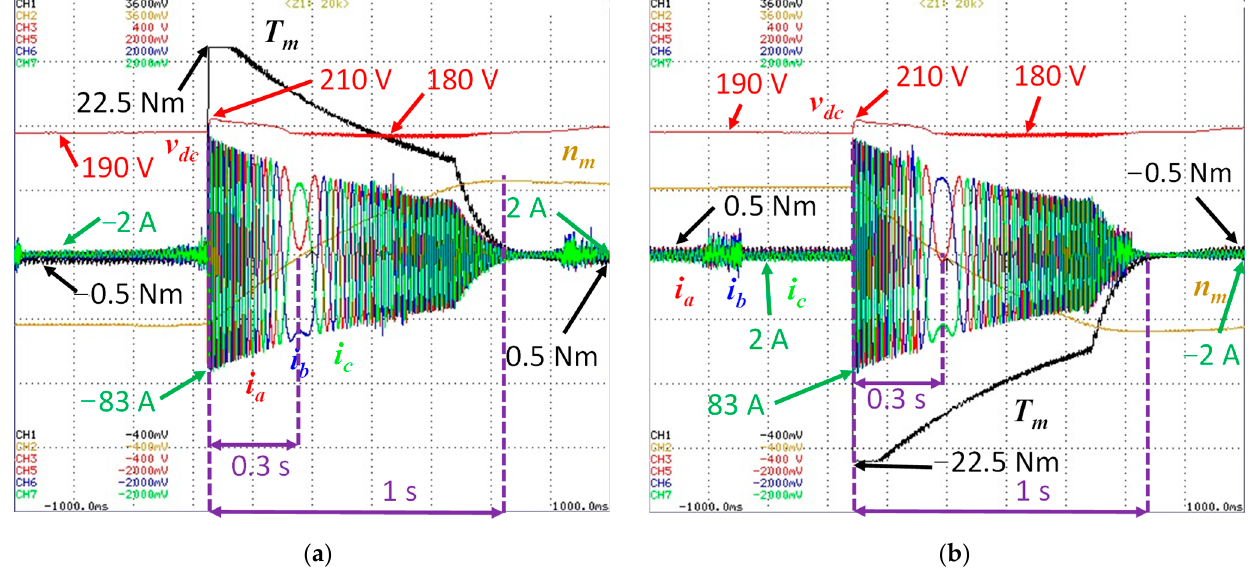
Figure 19. Experimental results of the traction system: the torque ( T m ) and speed ( n m ) of the SRPM machine, dc-link voltage ( v dc ) and stator windings’ currents ( i a , i b , i c ) when inverting the rotation direction without a load: ( a ) − 1000 rpm to 1000 rpm; ( b ) 1000 rpm to − 1000 rpm.